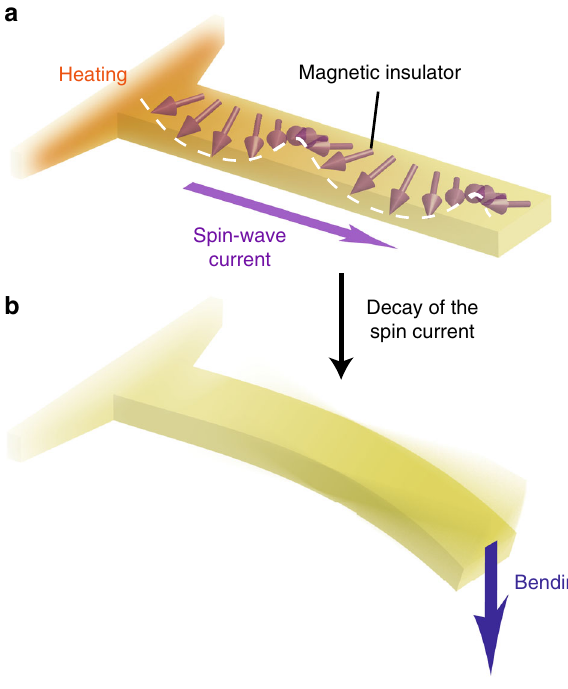
Fig. 1 Schematic illustration of spin Seebeck mechanical force. a A schematic illustration of spin Seebeck effects. When a part of a magnetic insulator is heated, a spin wave is excited and fl ows out of the part: the spin-wave spin Seebeck effect. A spin wave carries angular momentum. b Relaxation of spin waves generates macroscopic mechanical torque and force due to the angular momentum transfer